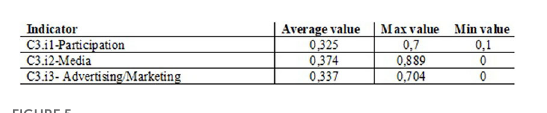
FIGURE4 Average, maximum and minimum values obtained by each indicator composing criterion Services (C2).